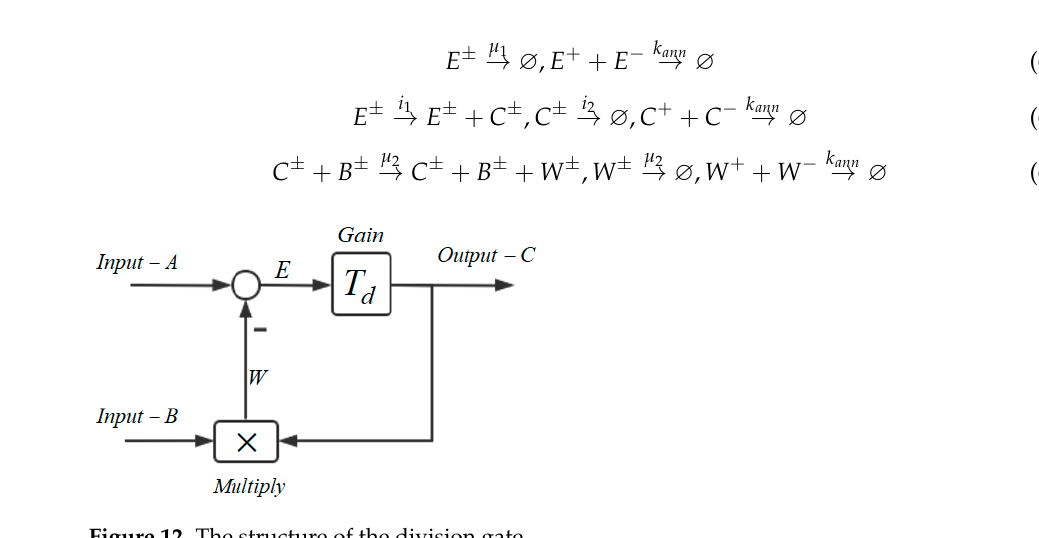
Figure 14. The 2DOF IMC-PID division gate control system.